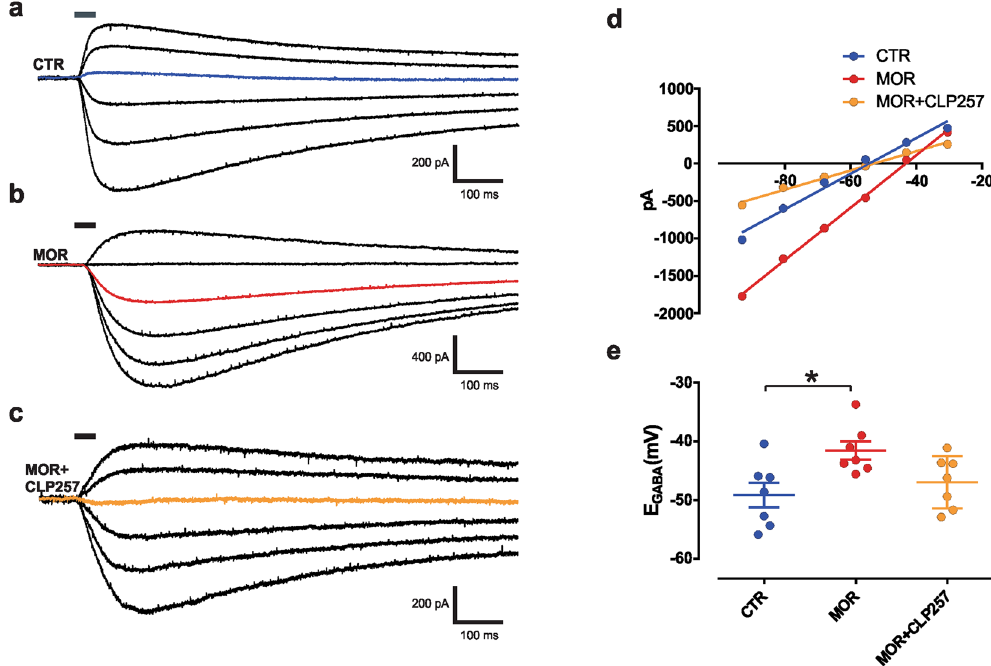
Figure 1. Acute CLP257 restores Cl − extrusion in SDH neurons of morphine-treated rats. ( a – c ) Voltage clamp responses at different holding potentials to 30-ms muscimol puffs ( solid line ) in SDH neurons following saline ( a ) or morphine ( b ) treatments in the presence of a Cl − load (29 mM) to measure Cl − extrusion capacity. In ( c ), muscimol response in a SDH neuron from a morphine-treated rat obtained after slice pre-incubation with CLP257 (100 µ M) for 1 hour. The colored line indicates the response at − 55.5 mV (note the change in polarity). ( d ) I - V relationships for GABA A currents obtained from neurons in ( a – c ). ( e ) Pooled E GABA in controls ( n = 7 cells, blue ), in morphine-treated rats ( n = 7 cells, red ) and following CLP257 treatment ( n = 7 cells, orange ). E GABA is significantly more depolarized following morphine treatment as compared to control rats (one- way ANOVA, P = 0.02, Tukey post-hoc * P = 0.02), but not after CLP257 pre-incubation ( P = 0.7); MOR vs . MOR + CLP ( P = 0.1). Abbreviations: CTR = control; MOR = morphine; SDH = superficial dorsal